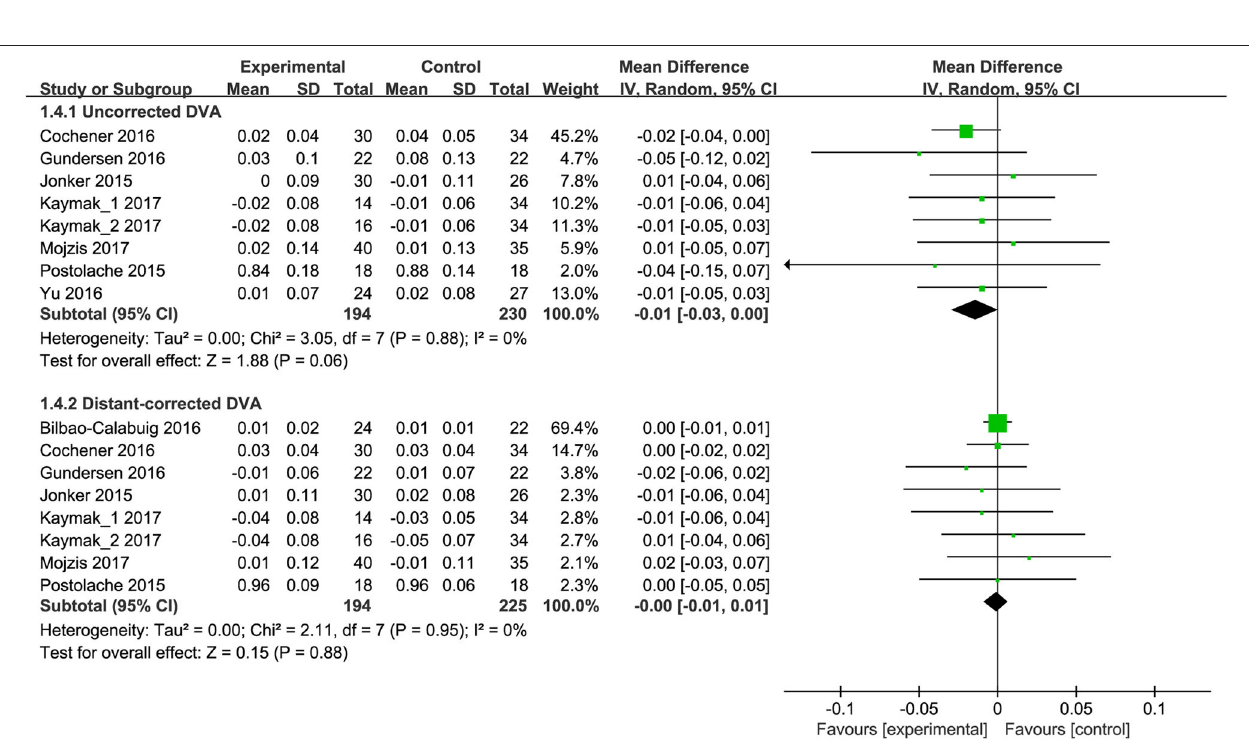
FIGURE 5 | Meta-analysis of DVA between trifocal and bifocal IOLs. SD, standard difference; IV, inverse variance; CI, confidence interval; DVA, distant visual acuity. Experimental and control indicate trifocal and bifocal IOLs, respectively.